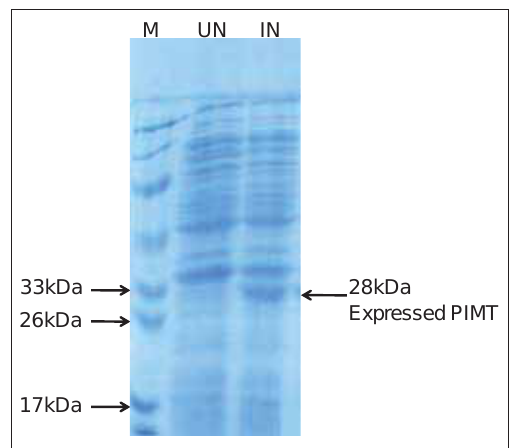
Figure-4: SDS-PAGE analysis of Escherichia coli bacterial cel lysate following induction of IPTG. Lane UN and IN are uninduced and induce cultures. Lane: M is the protein